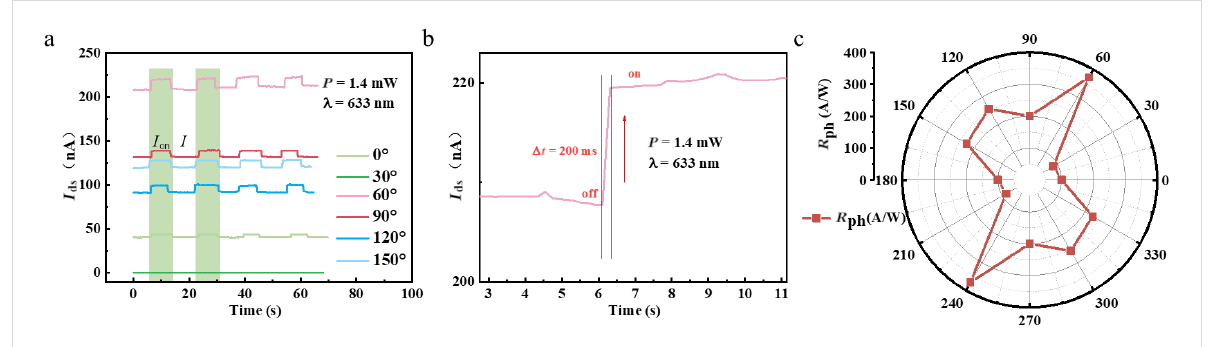
Figure 5: Angle-resolved photocurrent response of the photodetector based on 1T’-WTe 2 . a) Real-time photocurrent response of different test angles (from 0° to 150°, spaced at 30° apart) under the following conditions: V ds = 5 mV, incident power = 1.4 mW, incident wavelength = 633 nm. b) The magnified photocurrent response of test angle at 60° with a response time of around 200 ms. c) Angle-resolved photosensitivity of the